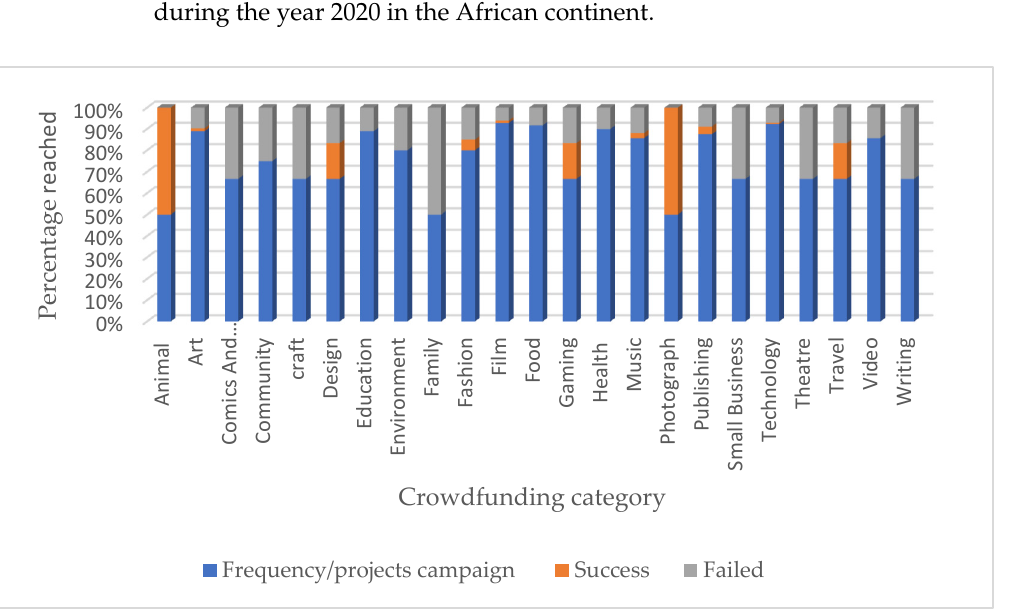
Figure 4. Total amount raised. Source: Authors’ own compilation. The duration of the campaigns is presented in Figure 5. Typically, the time frame for projects to raise money ranges from 30 to 90 days. The more successful projects have a duration that ranges from 26 to 31 days with the crowdfunding campaign reaching over 100% of its target. From 60 days upward, the success rate drops, compared to 29 to 36 days, which showed success rates of over 119% to 385%. It is advisable for project creators to aim for a campaign that lasts between 26 to 36 days to ensure success.